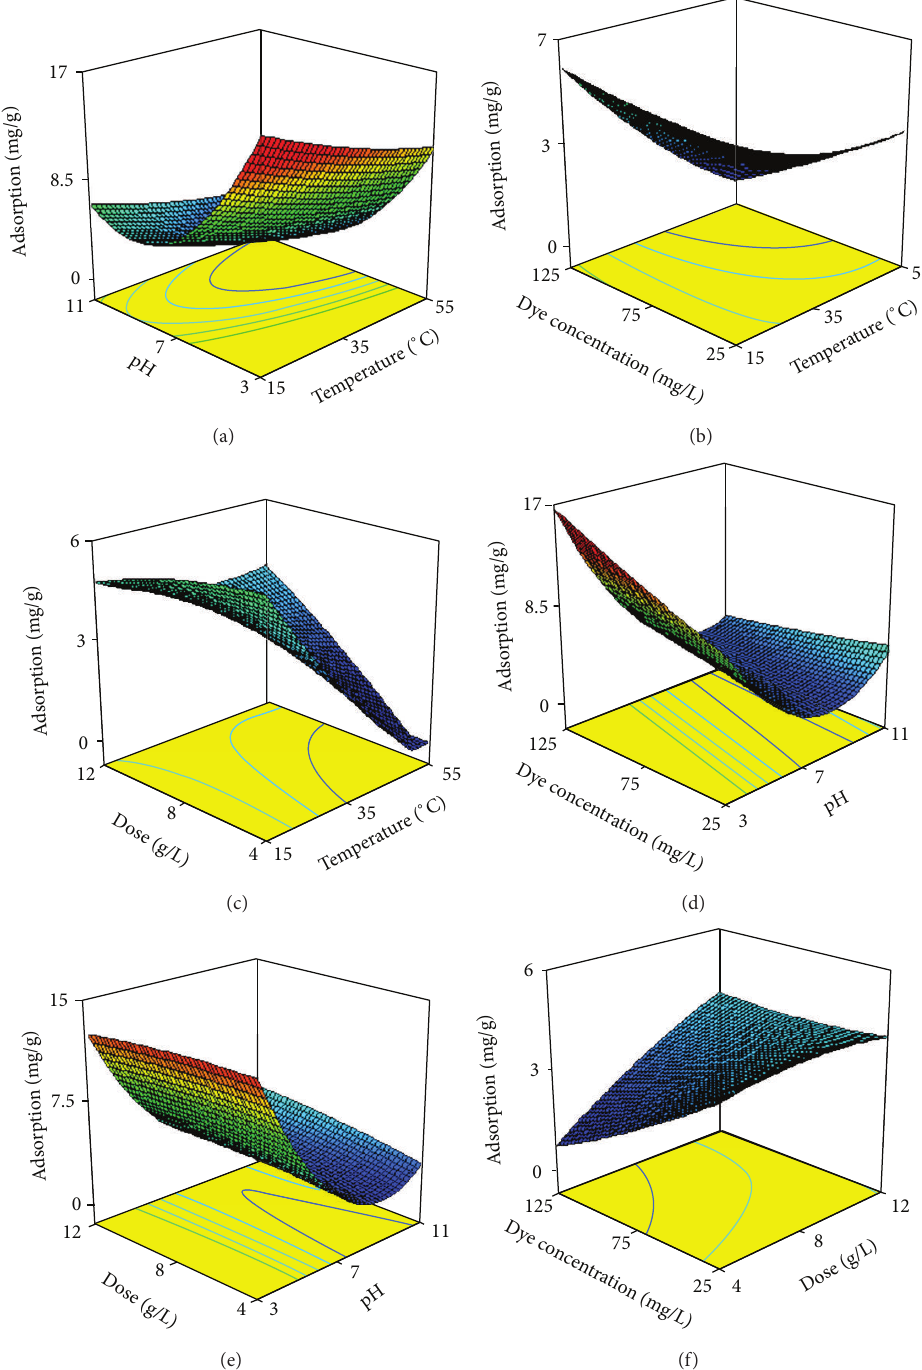
Figure6:The3Dplotsshowingeffectof(a)pHandtemperature,(b)temperatureandinitialdyeconcentration,(c)temperatureandadsorbent dose, (d) pH and initial dye concentration, (e) pH and adsorbent dose, and (f) initial dye concentration and adsorbent dose on the adsorption of